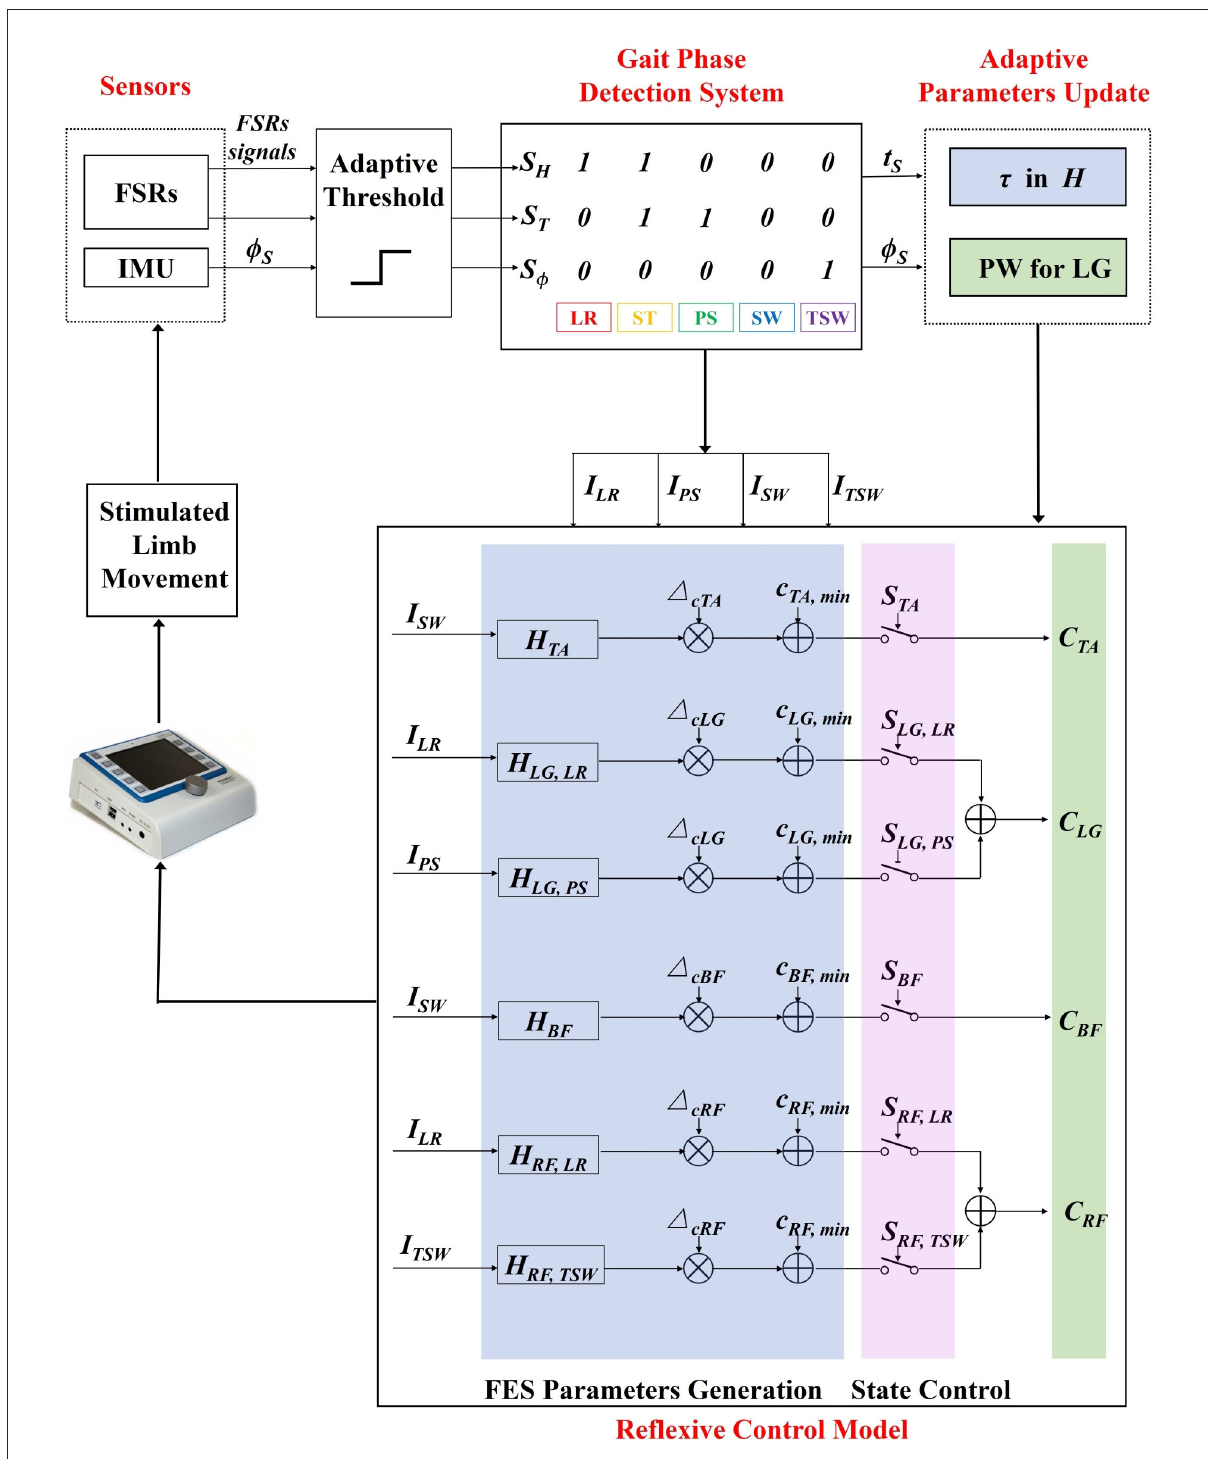
FIGURE2 The adaptive reflexive FES control diagram. Input signals are first translated into binary signals by an adaptive threshold. Gait phases are identified based on a rule-based machine learning algorithm. Gait event impulses are generated when specific gait transitions between gait phases occur. A hierarchical FES control model consists of two levels of control where the top level switches the stimulation state of muscles, and the low level generates the stimulation sequences. The time constant parameter τ and stimulation pulse width are adaptively updated with an iterative learning method in the low level controller based on the real-time feedback of muscle stimulation time t s and sagittal shank angle φ TO , respectively. LR, load response; ST, stance; PS, pre-swing; SW, swing; TSW, terminal